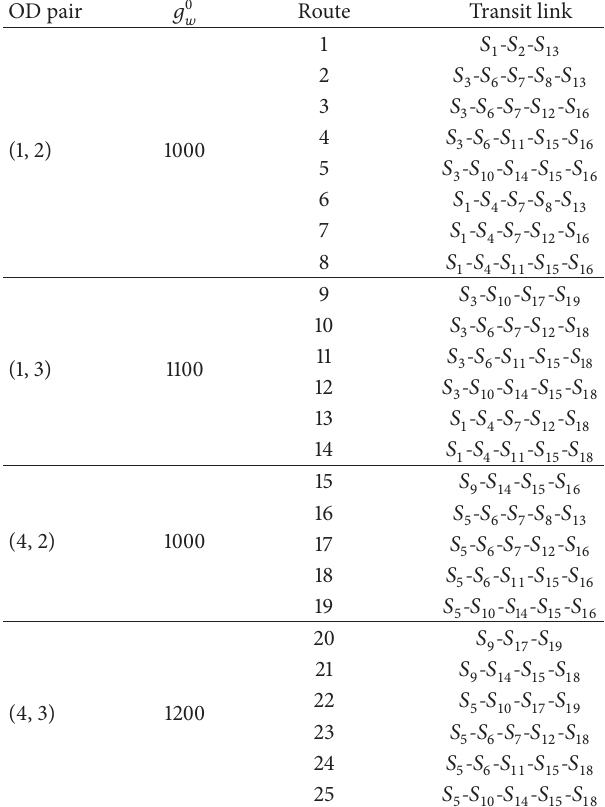
Table 3: The relationship between transit line and transit link. Transit